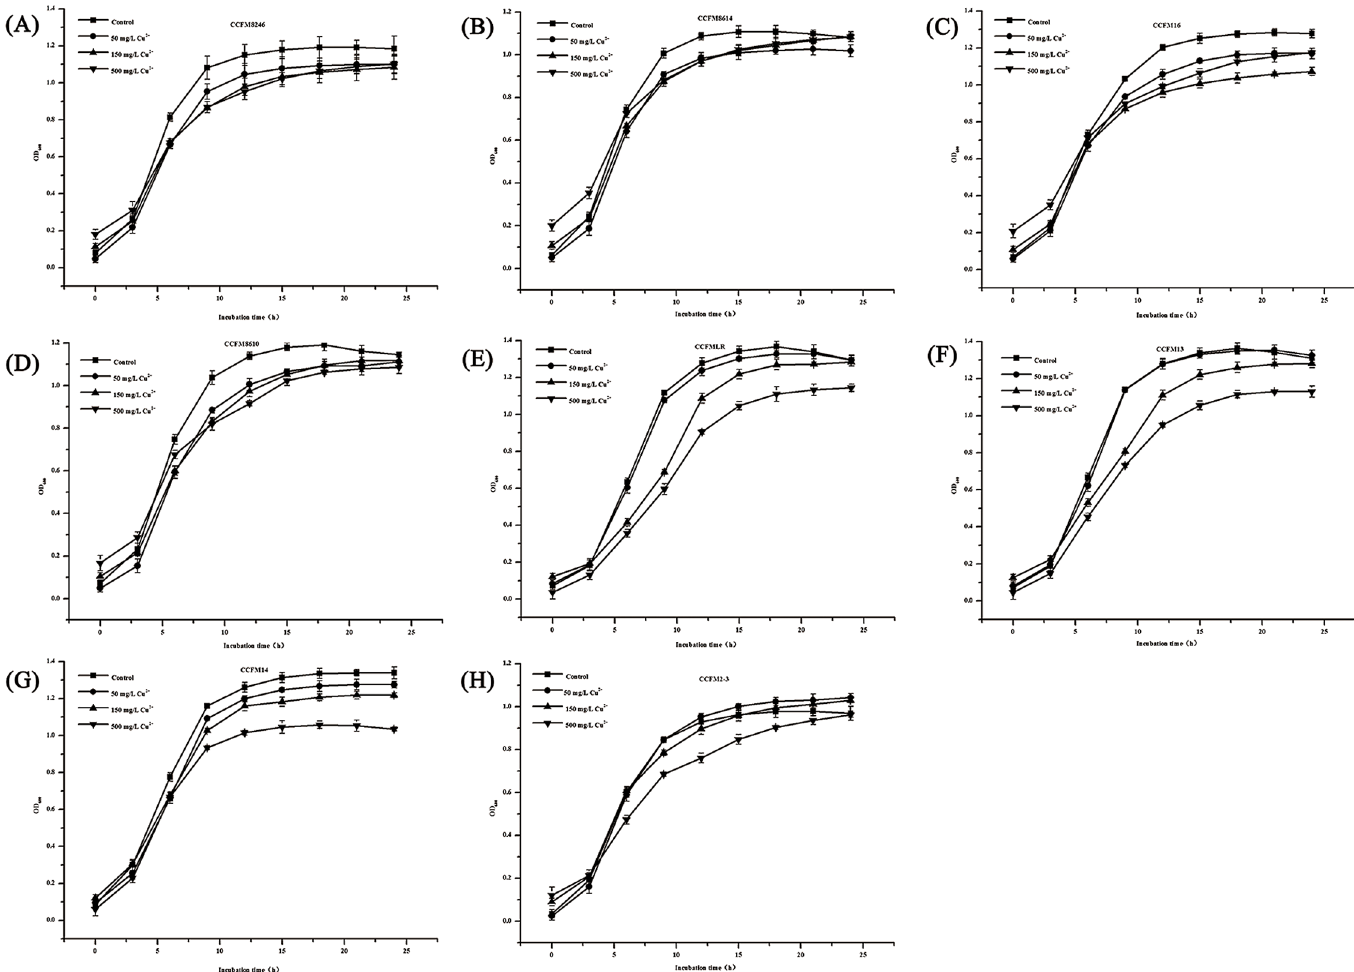
Fig 3. The second kind of growth of strains in different copper ion MRS broths. The subgraphs (A) to (H) show the tolerance ability of CCFM8246, CCFM8614, Bifidobacterium , CCFM8610, CCFMLR, CCFM13, CCFM14 and CCFM2-3, respectively.